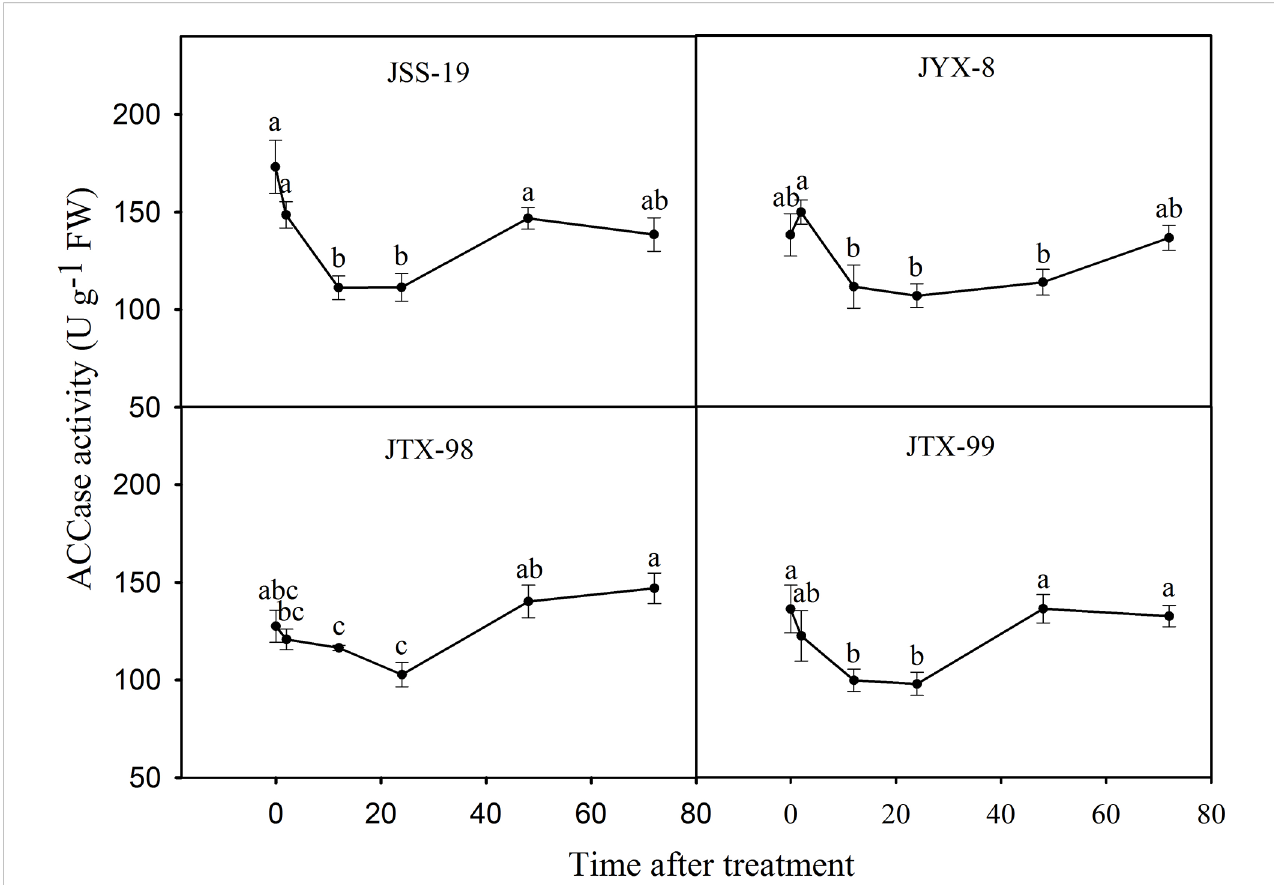
FIGURE 4 ACCase activities in four populations of D . ciliaris var. chrysoblephara after metamifop treatment. ACCase activities were determined using the ammonium molybdate spectrophotometric method. ACCase activities in resistant populations were less inhibited than in sensitive populations and also recovered to the same or even higher levels compared to untreated plants. Vertical bars indicate standard errors. Different lowercase letters indicate statistically signi fi cant differences (P < 0.05) based on Tukey ’ s